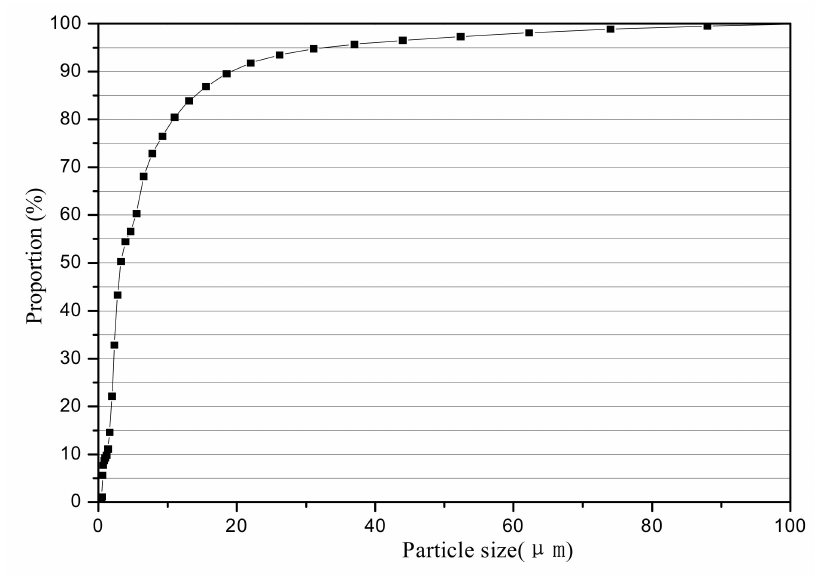
Figure 3. Particle distribution of the original TSS